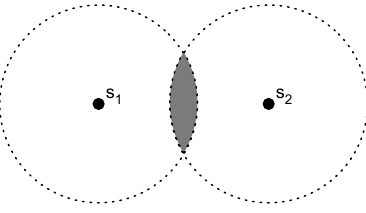
Figure 5. Proximity method